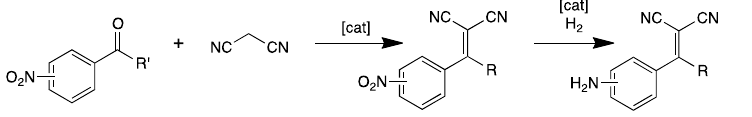
Figure 2. TEM images of the PdNPs on triazine-based-g-C 3 N 4 nanotubes (( a ) and ( b )). Inset in ( b ) shows crystallographic planes of fcc Pd(0) [24]. Reproduced from [24] with permission from Elsevier. Table 1. Comparison of the reported catalytic activity to the sequential condensation/reduction synthesis of α -alkylated nitriles.